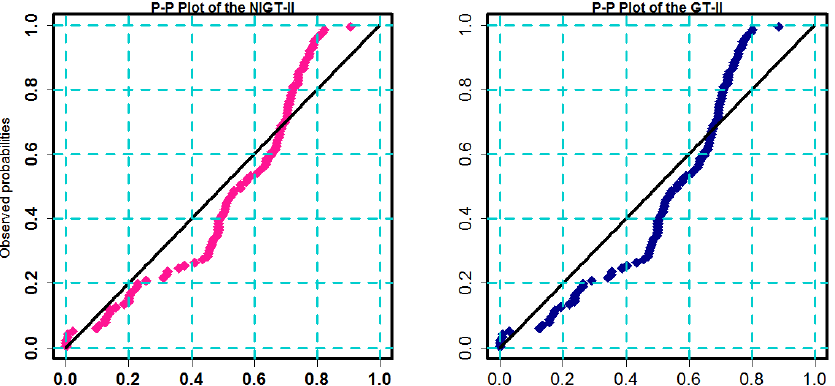
Fig. 8. Probability plots of NIGT-II and GT-II models for dataset II. Figure 8. Probability plots of NIGT-II and GT-II models for dataset II.